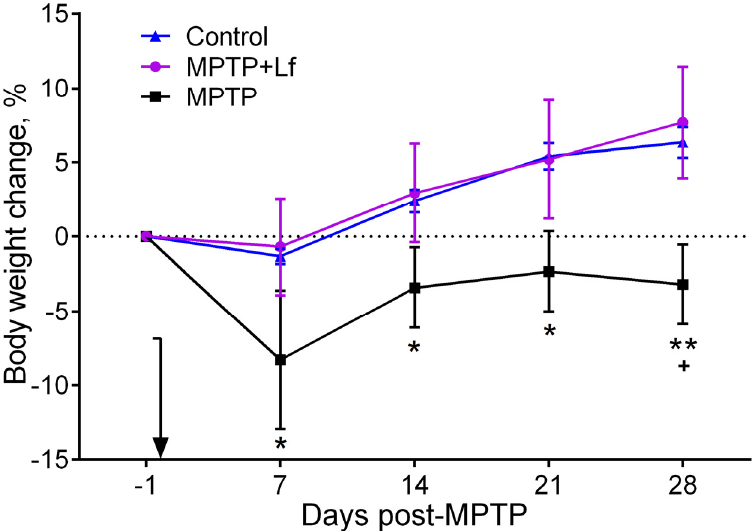
Figure 2. Body weight change (%) in the MPTP/saline-treated mice. The arrow indicates when MPTP/saline was administered. Values are presented as mean ± SEM. * p < 0.05, ** p < 0.01—compared to the Control group (saline-treated); + p < 0.05 compared to the MPTP + Lf group at an each time point (Kruskal–Wallis ANOVA followed by post hoc Dunn’s multiple comparisons test).